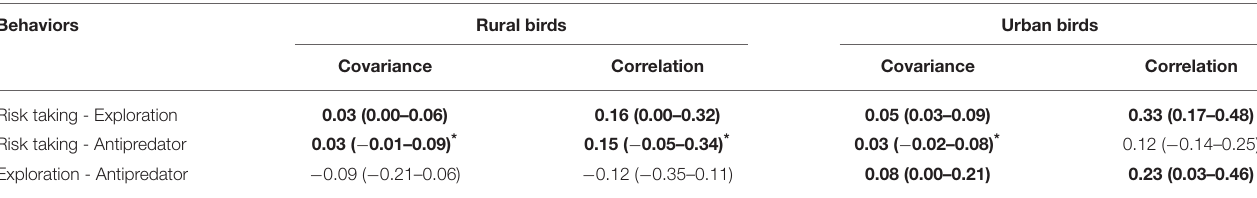
TABLE 2 | Mean covariances and correlations, with their 95% credible intervals in brackets, obtained for risk taking (measured as FID), exploration (measured as latency in approaching a new food source) and antipredatory behavior (measured as latency in approaching a predator) in rural and urban burrowing owls Athene cunicularia .